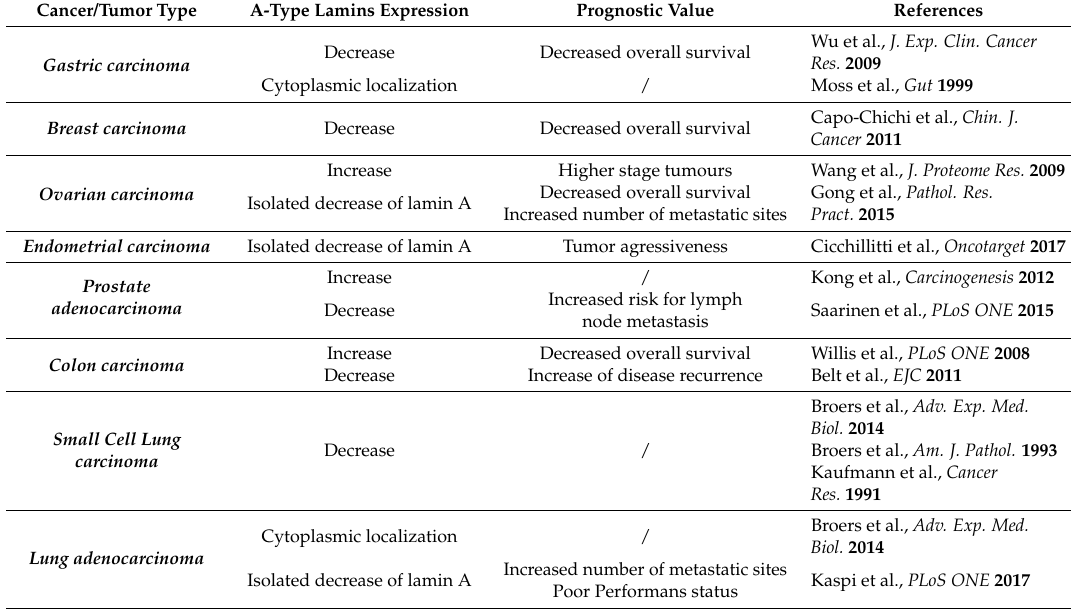
Table 1. Summary of A-type Lamins expression (at a protein level) depending on tumor type and link with the prognostic